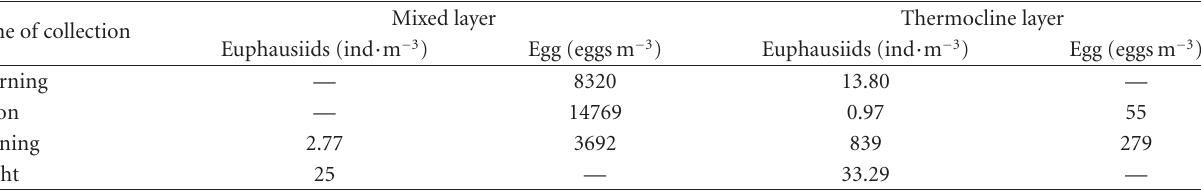
Figure 7: Abundance (ind · m − 3 ) of euphausiids during early and peak phases of summer monsoon (a) in the mixed layer and (b) thermocline layer along 8 ◦ N, (c) in the mixed layer and (d) thermocline layer along 10 ◦ N. Table 4: Abundance (ind · m − 3 ) of euphausiids and euphausiid eggs (eggs m − 3 ) observed during the diurnal collection at station 6 (“—”